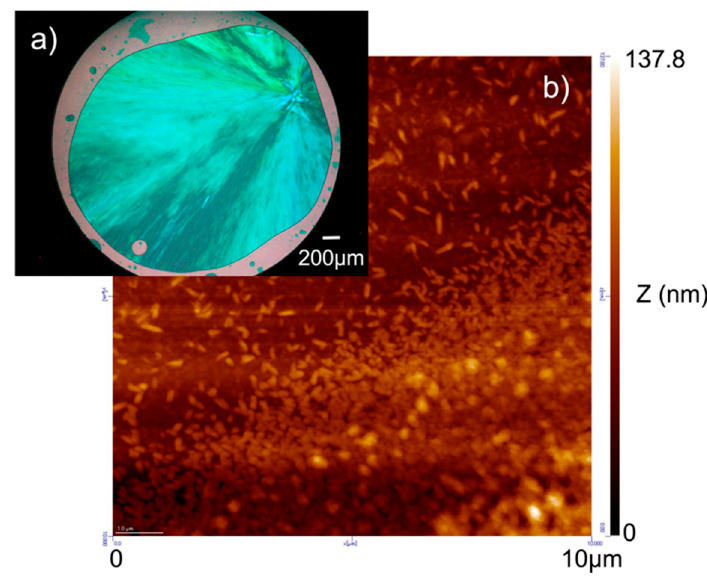
Figure 6. ( a ) Polarized optical microscope and ( b ) AFM images (substrate: mica) of 1 film prepared from cooling from isotropic liquid.